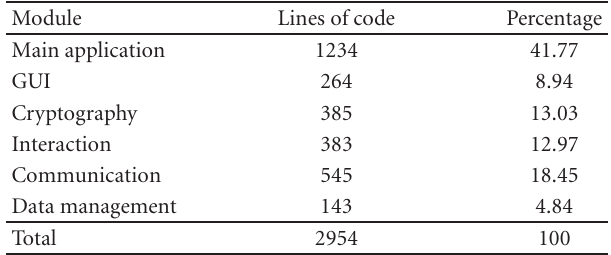
component. (cid:3)(cid:4)(cid:5)